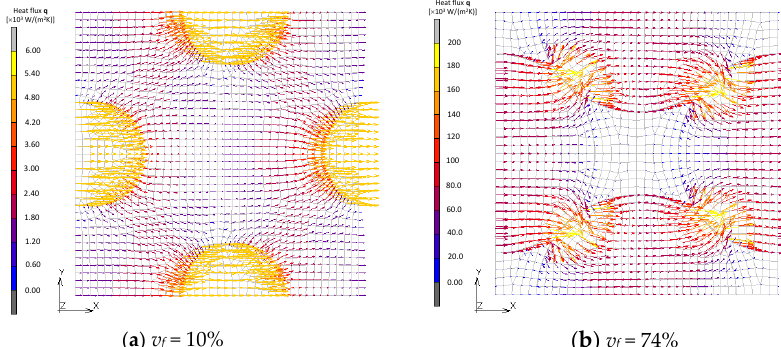
Figure 14. Heat flux field of FCC models.